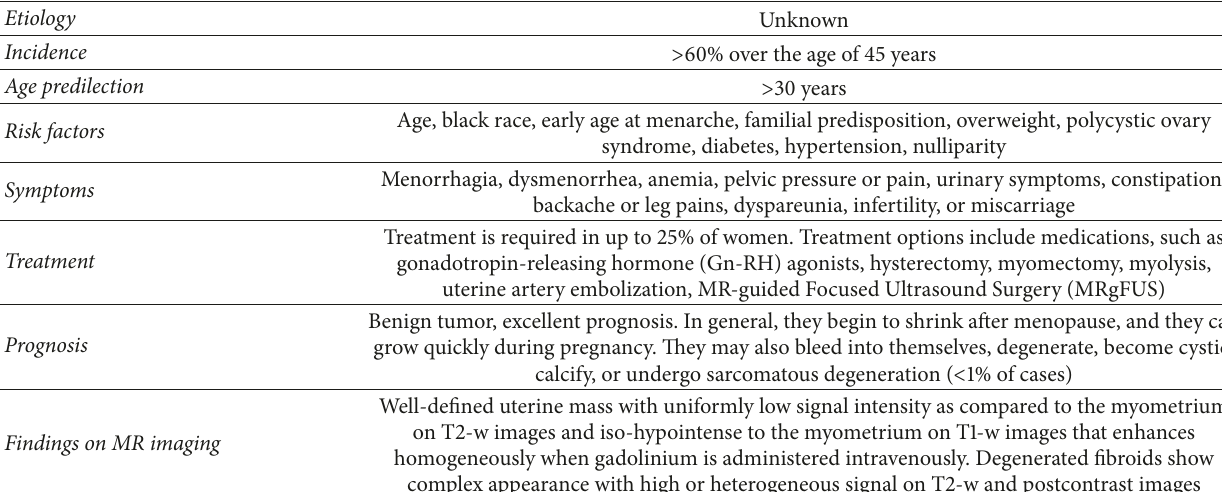
Table 1: Summary table for uterine